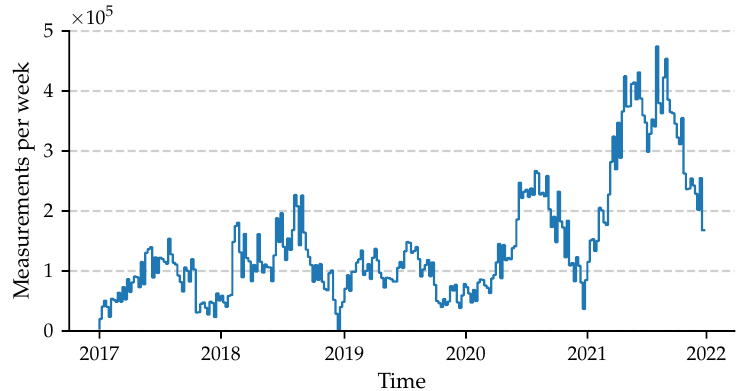
Figure 5. Weekly ADS-B measurements in the filtered data set.